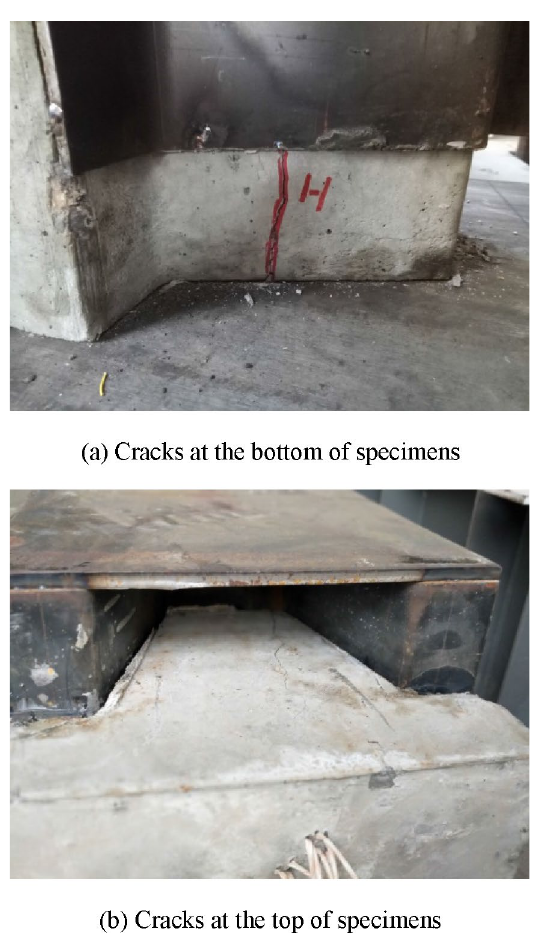
Figure 7. Concrete cracks in a specimen during